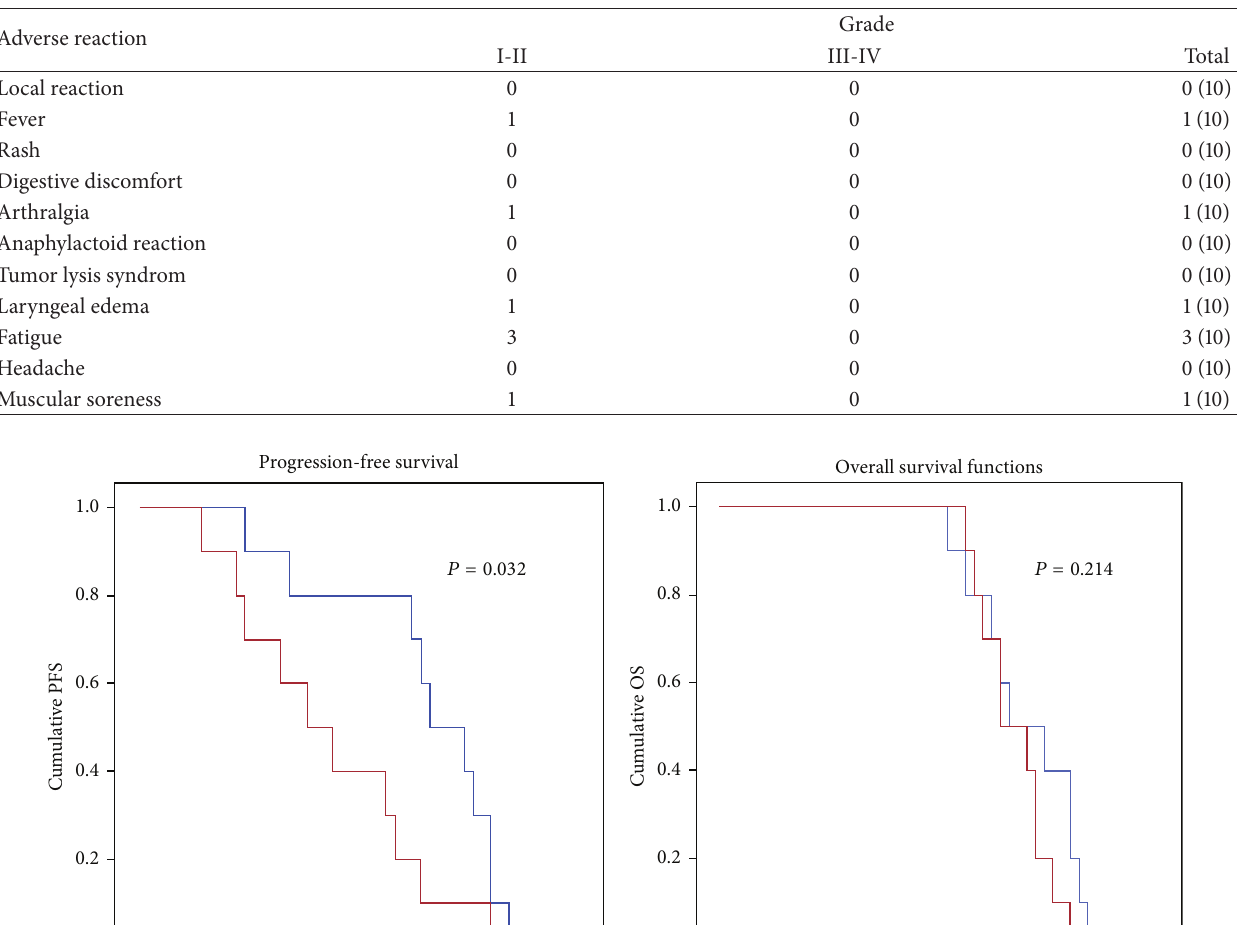
Table 4: Adverse effects and response status.